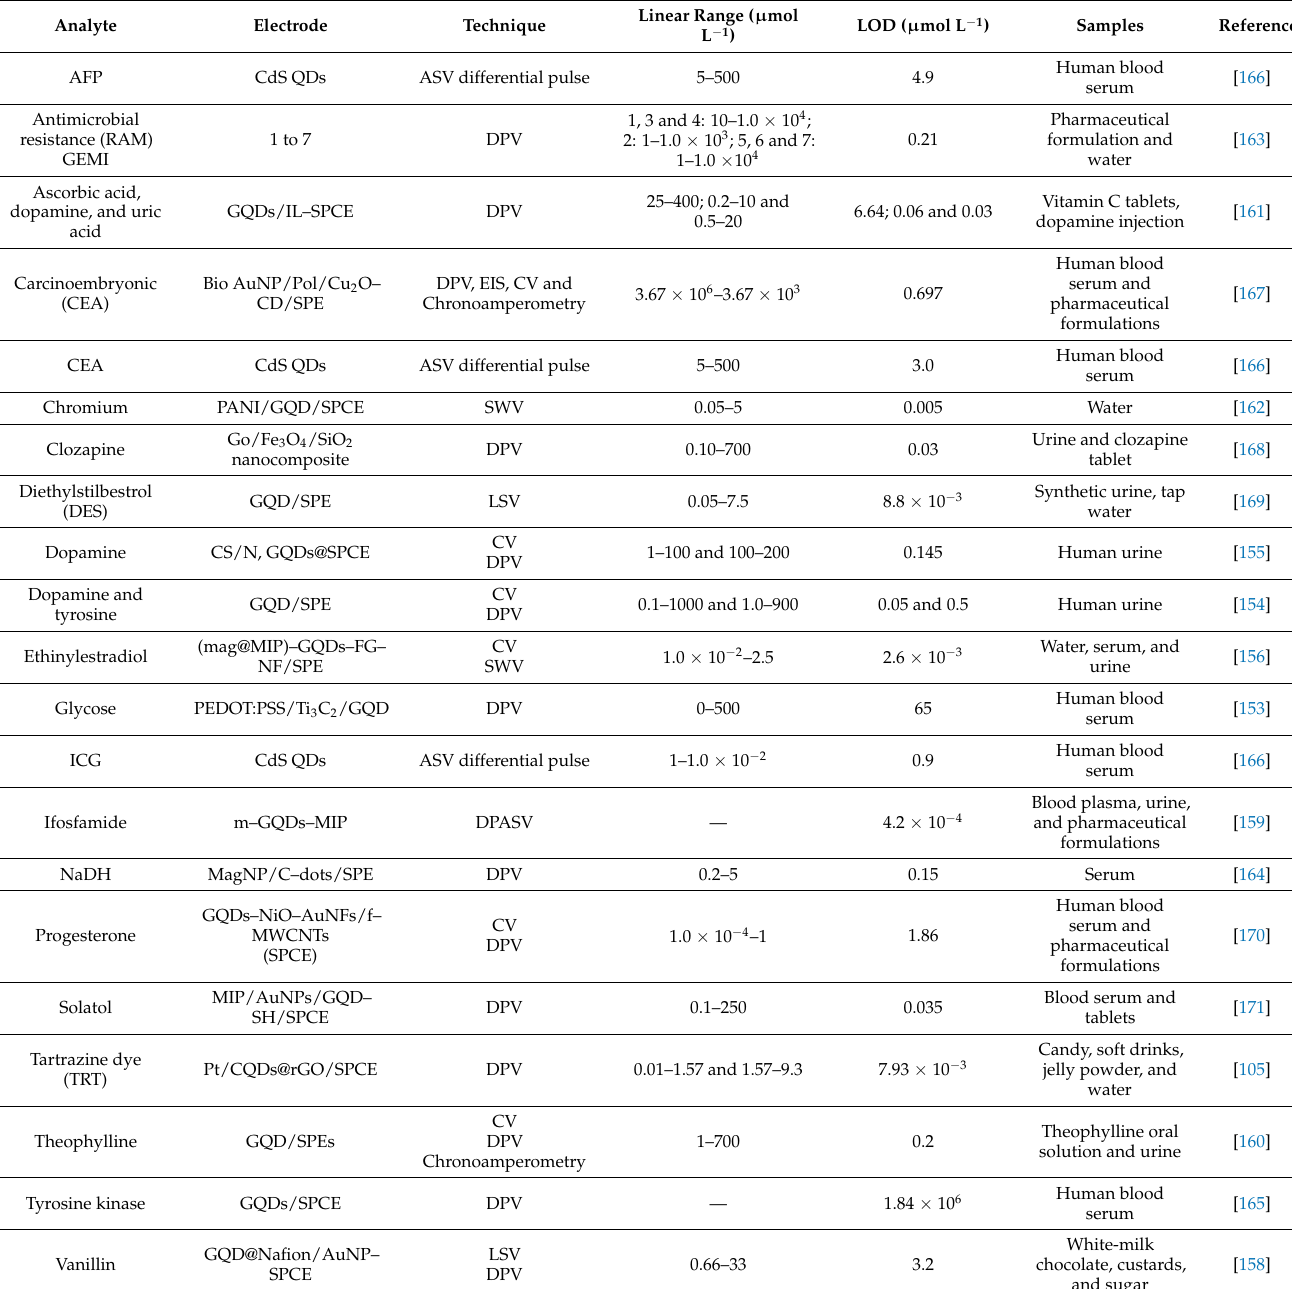
Table 4. Electrochemical sensors based on carbon quantum dots